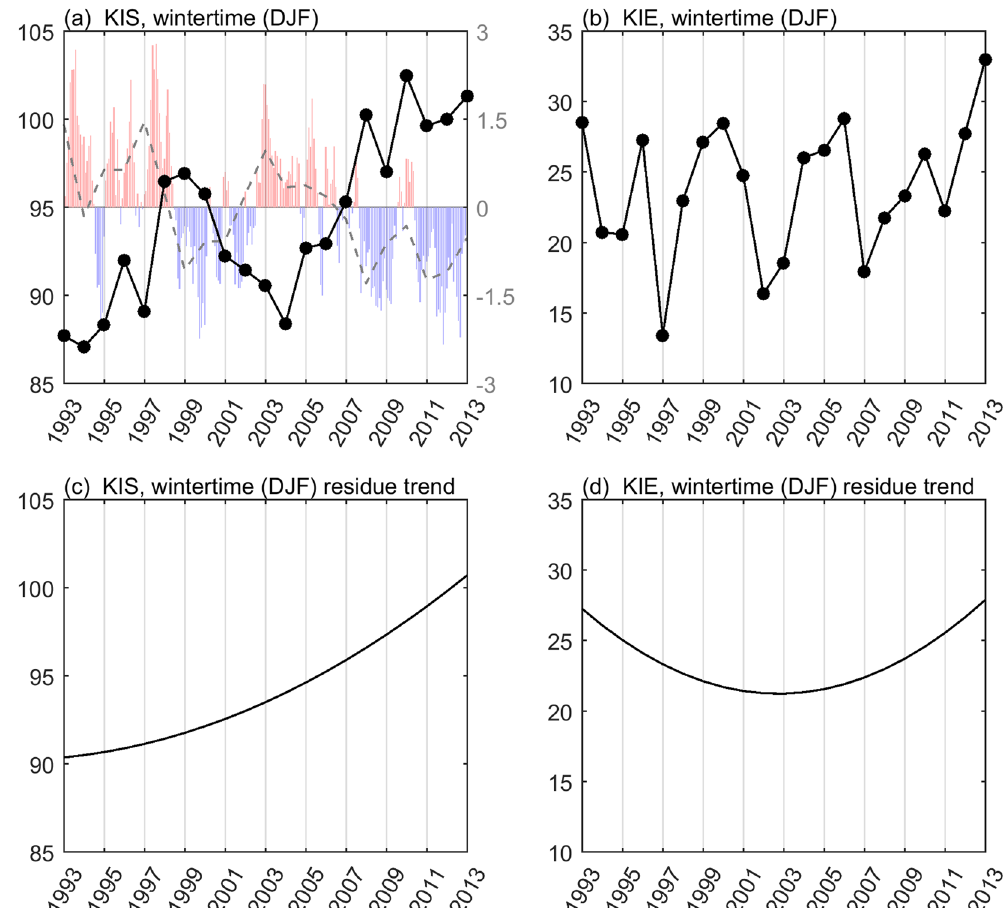
Figure 2. Kuroshio intrusions into China Seas during wintertime (Dec-Jan-Feb, 1993–2013). ( a ) Time series of winter-only KIS index (in units of cm). Positive (negative) PDO indices are also shown in red (blue) colored bars. Dashed line is the yearly mean PDO index. ( b ) Time series of winter-only KIE index (in units of cm s − 1 ). ( c , d ) Same as the black lines with dots in Fig. 2a and b, except for the residue trend of winter-only KIS and KIE indices, respectively. All figures are generated with MATLAB (R2017a;